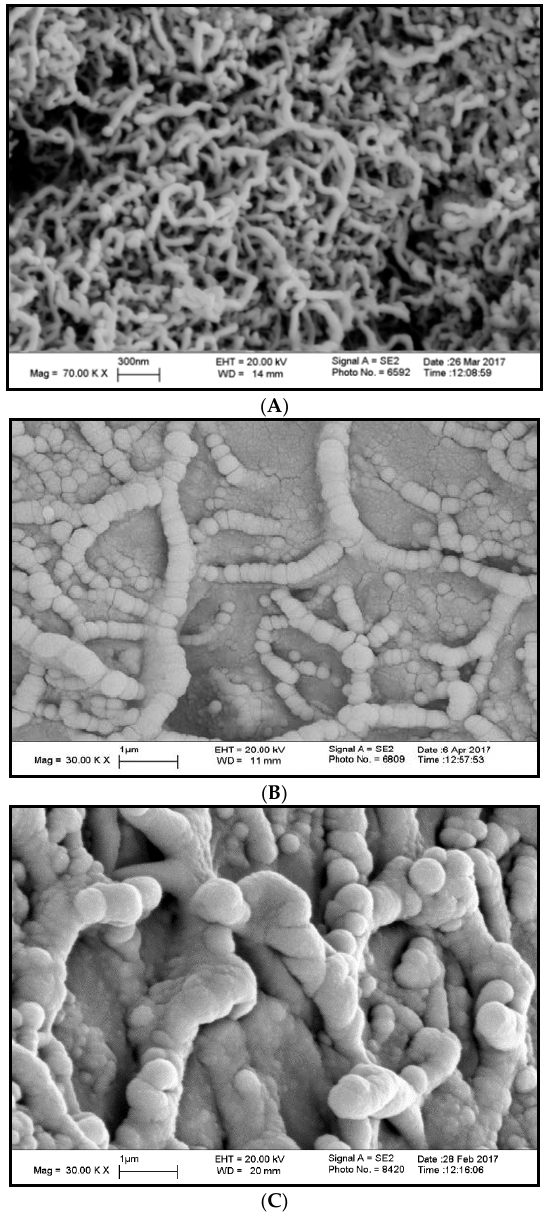
Figure 3. SEM micrographs: CNT pristine ( A ), Ar-CNT-P ( B ) and Ar-CNT-C ( C ) composites with 5 wt % of CNTs.